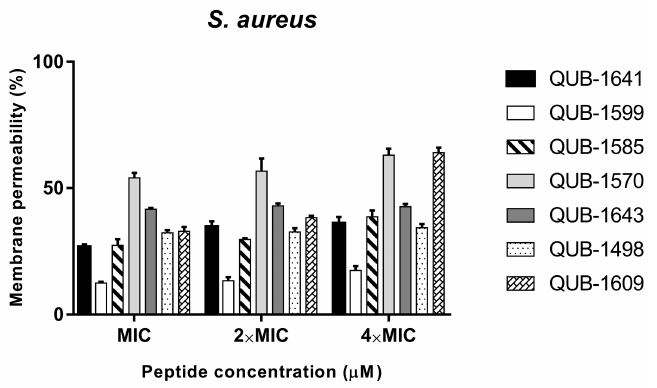
Figure 9. Membrane permeability of QUB-1641 and its analogues against S. aureus . The positive control was 70% isopropyl alcohol and bacterial suspension. The data represented the ± SEM of five replicates.